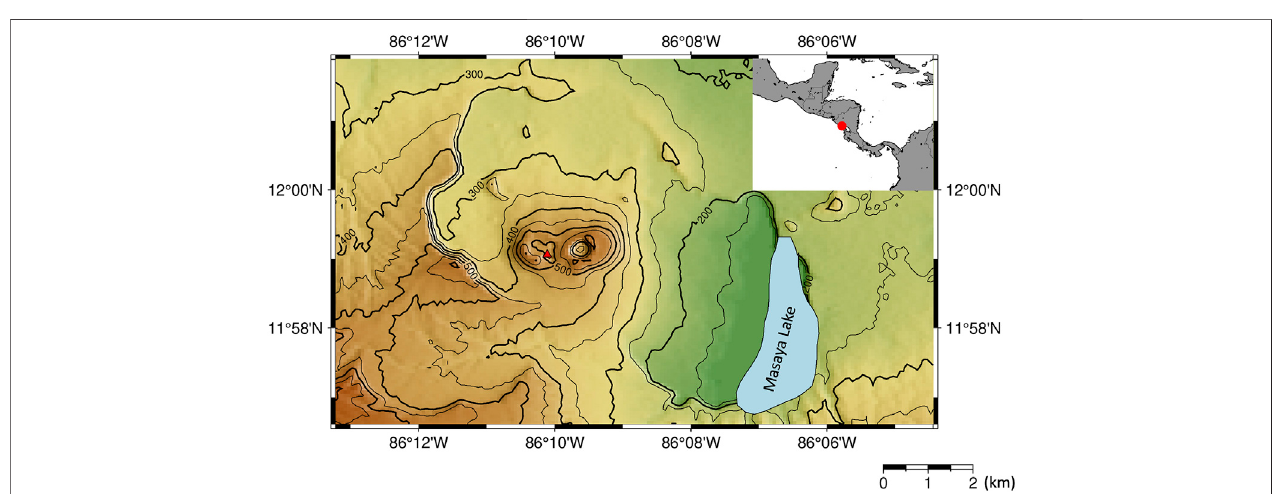
Frontiers in Earth Science |